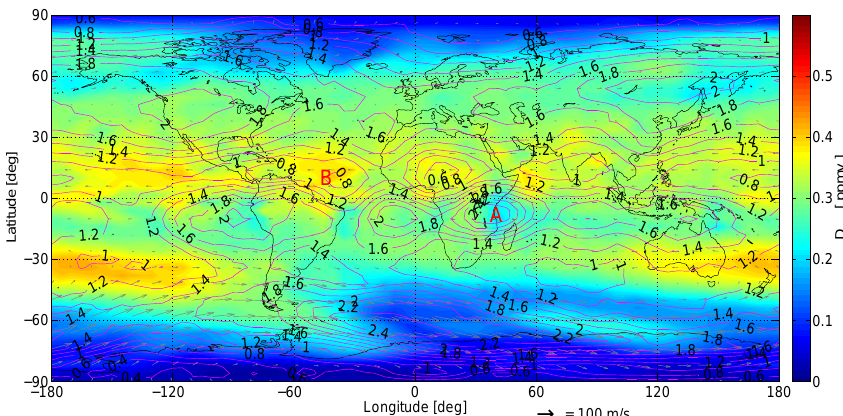
Figure 7c. Same to Fig. 7a with simulation data from September. Temperature-correlated effects of region A and B are discussed in Sect. 6.1.